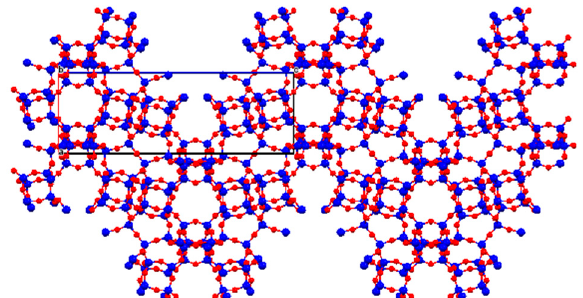
Figure 1. Representation of the STW topology obtained thanks to the .cif from the IZA Database website (with permission from Reference [9], copyright © 2018 Structure Commission of the International Zeolite Association (IZA-SC) [9]) using the Mercury program [10].